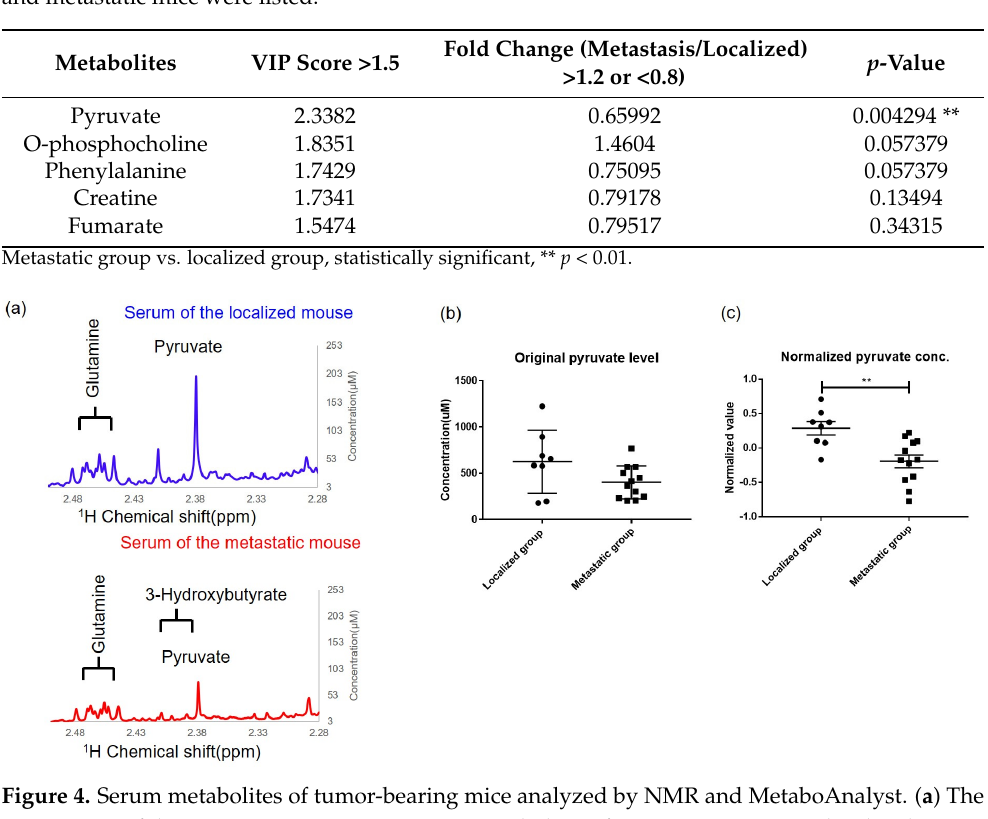
Figure 4. Serum metabolites of tumor-bearing mice analyzed by NMR and MetaboAnalyst. ( a ) The comparison of the representative certain serum metabolites of NMR spectrums in a localized mouse and metastatic mouse were displayed. The serum pyruvate level was decreased in the metastatic mouse. ( b ) There was a slightly lower original pyruvate level in the serum of the metastatic group (localized group, pyruvate level: 626.2 ± 121, N = 8 vs. metastatic group, pyruvate level: 404.2 ± 51.12, N = 12, p = 0.07). ( c ) The pyruvate serum levels were processed and normalized by median, log transformation, and Pareto scaling in data processing in MetaboAnalyst software. The significantly lower pyruvate level in serum of the metastatic mice (localized group, N = 8, normalized pyruvate level: 0.29 ± 0.27 vs. metastatic group, N = 12, normalized pyruvate level: − 0.19 ± 0.32 **, respectively, ** p <